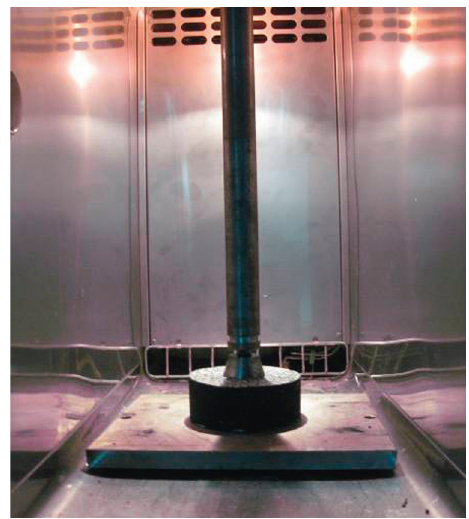
Figure 2: The dynamic penetration test equipment.